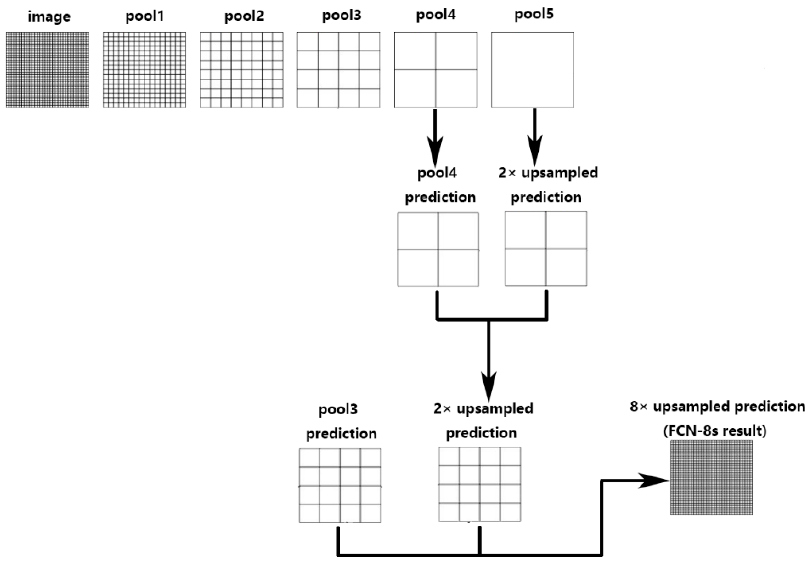
Figure 2. The architecture of FCN-8s.